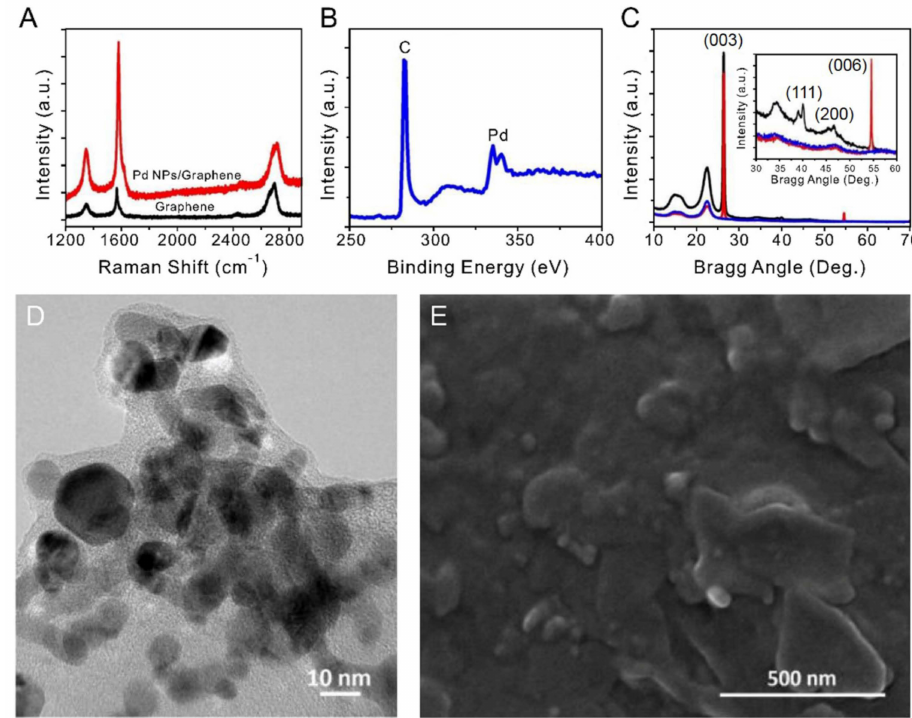
Figure 2. Characterization of the multilayered graphene sheet produced by pencil and confirmation of the presence of Pd NPs ( A ) Raman spectra of a multilayered graphene sheet and a multilayered graphene sheet decorated with Pd NPs. ( B ) XPS profile of the active area of a sensor. ( C ) XRD patterns of the active area of a sensor: plain paper (blue), multilayered graphene sheet / paper (red), and Pd NPs / multilayered graphene sheet / paper (black) were compared to confirm the presence of Pd NPs. Inset: enlarged spectra in the Bragg angle range of 30–60 ◦ used to identify Pd. ( D ) TEM image used to determine the size of Pd NPs. ( E ) SEM image showing morphologies of the graphene layer and Pd NPs; 6–7-nm Pd NPs are scattered widely between the multilayered graphene